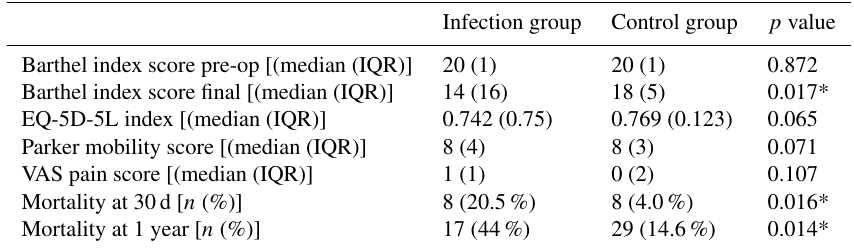
Table 3. Comparison between hip fracture patients with infection and without infection. Mann–Whitney U test was used for continuous variables and chi square for categorical.